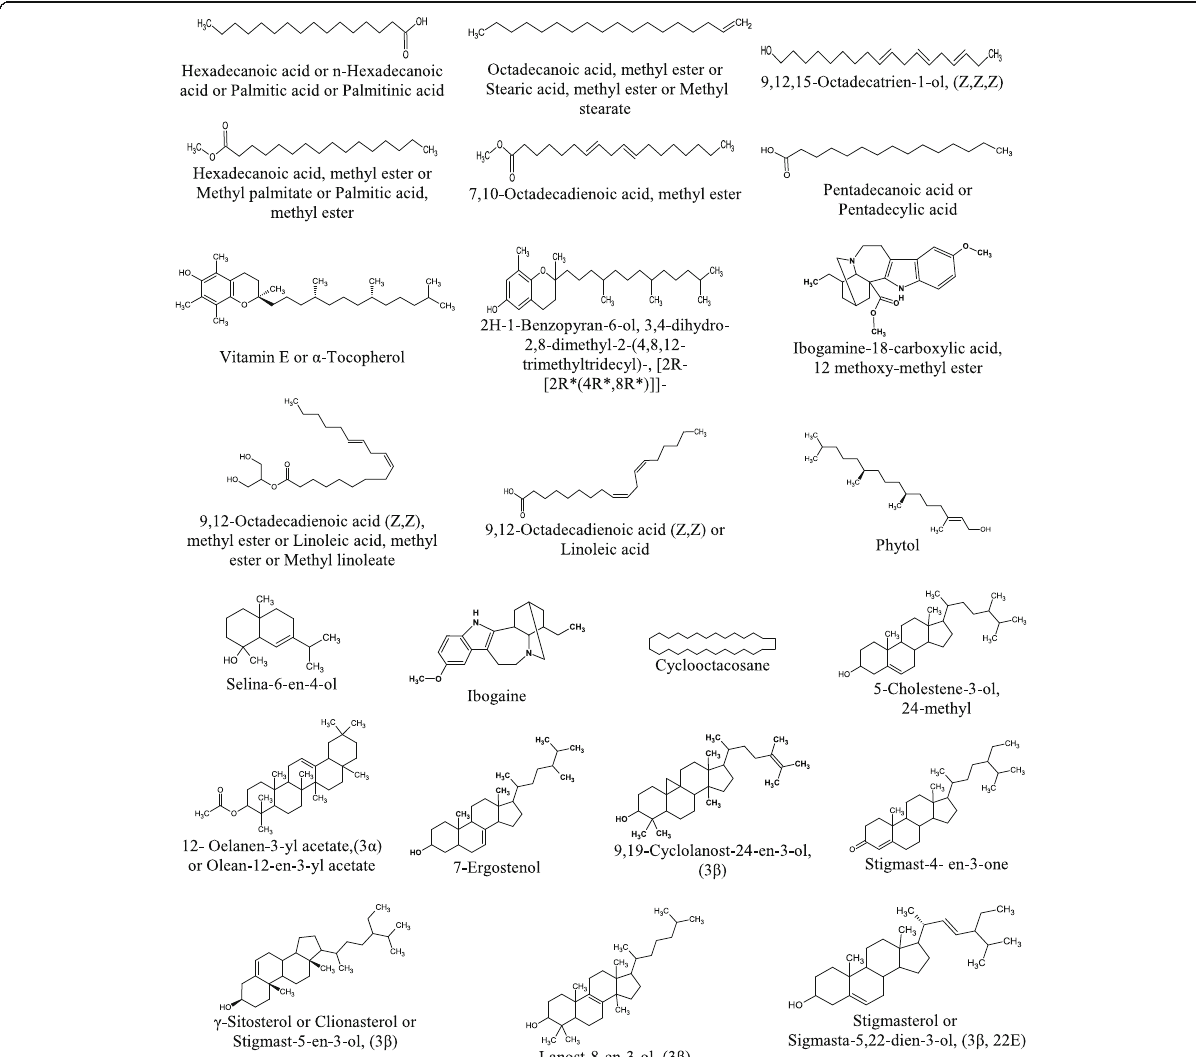
Fig. 2 Molecular structures of major compounds from each plant n-hexane partition based on gas chromatography-mass spectrometry chemometric